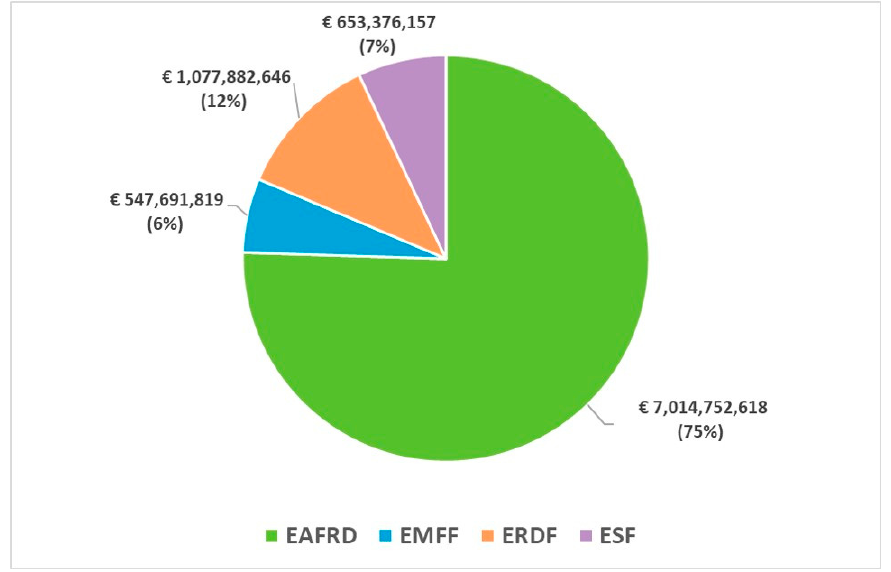
Figure 1. EU sources of CLLD (LAGs budgets) [7].